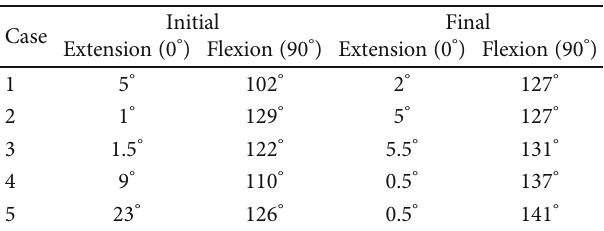
Figure 1: Preoperative weight bearing AP (a) and lateral (b) X-rays for Case 1. Table 1: The range of motion at maximum fl exion and extension in the initial and fi nal evaluations using the robotic knee